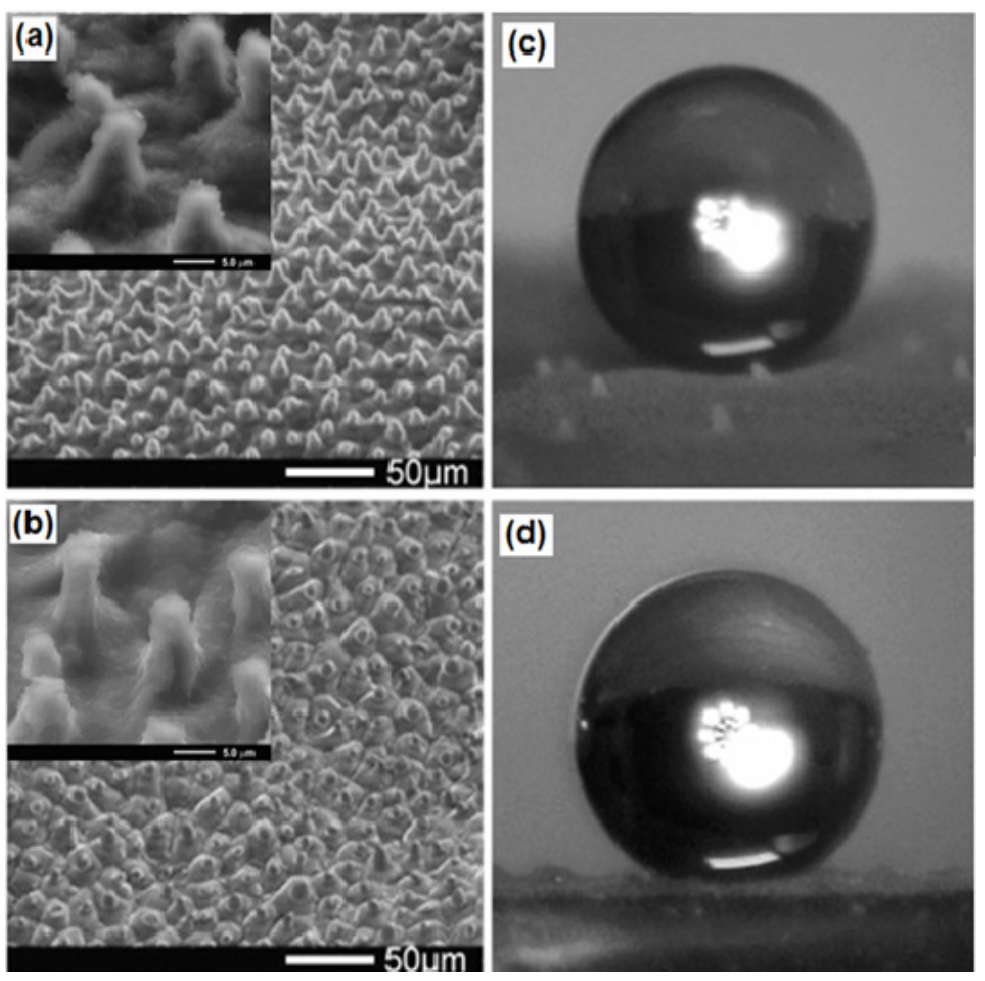
Figure 7. SEM images of: ( a ) the natural lotus leaf and ( b ) the superhydrophobic PDMS surface (respective insets shows the higher magnification images) and spherical water droplets on the ( c ) lotus leaf and ( d ) superhydrophobic PDMS surface. Images reprinted from [73], with permission from American Chemical Society, Copyright 2005.